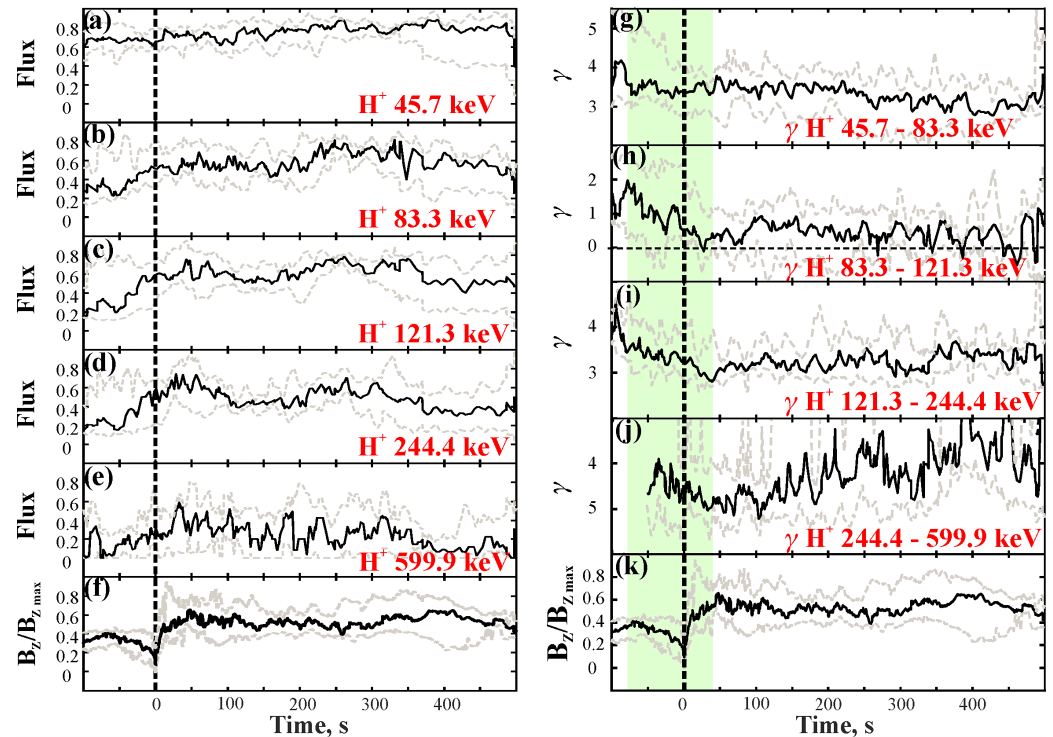
Figure 3. Panels (a) – (e) show the epoch profiles of H + ion fluxes with energies indicated in the corresponding panel. Panels (g) – (j) display the epoch profiles of γ calculated in the given energy ranges indicated in the corresponding panel. Panels (f) and (k) show the epoch profile of the normalized B Z magnetic field (see explanation in the text). The vertical dotted line marks the epoch time t = 0, which corresponds to dipolarization onset in each event from our database. The green-shaded area in panels (g) – (k) displays the time interval of the γ decrease. (t) and gray dashed lines show lower and upper quartiles of the corresponding The black lines display the median profiles of fluxes and B ∗ Z epoch